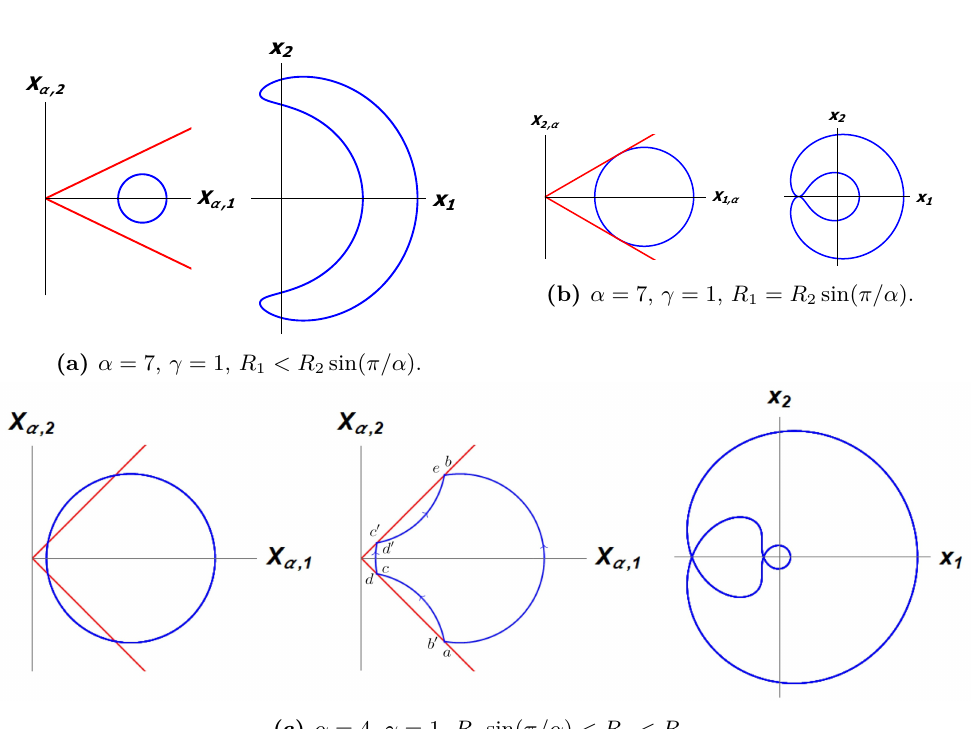
Figure 3. In figures 3a and 3b the trajectories of the particle in the ( X α, 1 , X α, 2 ) plane (left) and ( x 1 , x 2 ) plane (right) are presented. The two red lines indicate the sector of the angle 2 π/α , which correspond to the edges of the “cut and flattened” cone space that have to be identified to each other. In figure 3a the trajectory does not touch these lines, and therefore the particle’s orbit in ( x 1 , x 2 ) plane is a simple loop. In figure 3b the trajectory touches the boundaries in the same (identified) point, implying that there is a single point in the ( x 1 , x 2 ) plane through which the particle passes twice within the period of motion. Finally, the trajectory in the plane ( X α, 1 , X α, 2 ) crosses the boundaries in figure 3c (left), and to construct the real trajectory in the “flattened cone” space we use the identity of the edges, and the velocity vector in corresponding points at the edges is constructed by a parallel transport. So when the particle moves from point a to point b , it “reappears” at point b 0 on the opposite edge, and moves in the direction of point c , and so on. As a result, there are two points on the path in the plane ( x 1 , x 2 ) through which the particle passes twice within the period of motion. The same logic has to be employed in the analysis of the cases in which the origin of the plane ( X α, 1 , X α, 2 ) is encircled by the corresponding